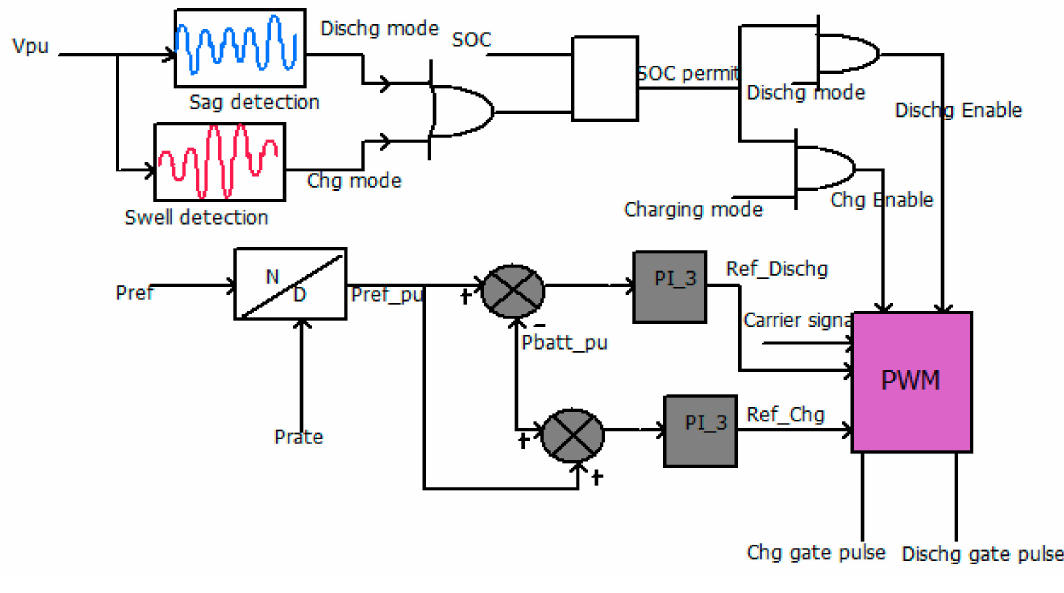
Figure 8. BES buck / boost converter controlling diagram.